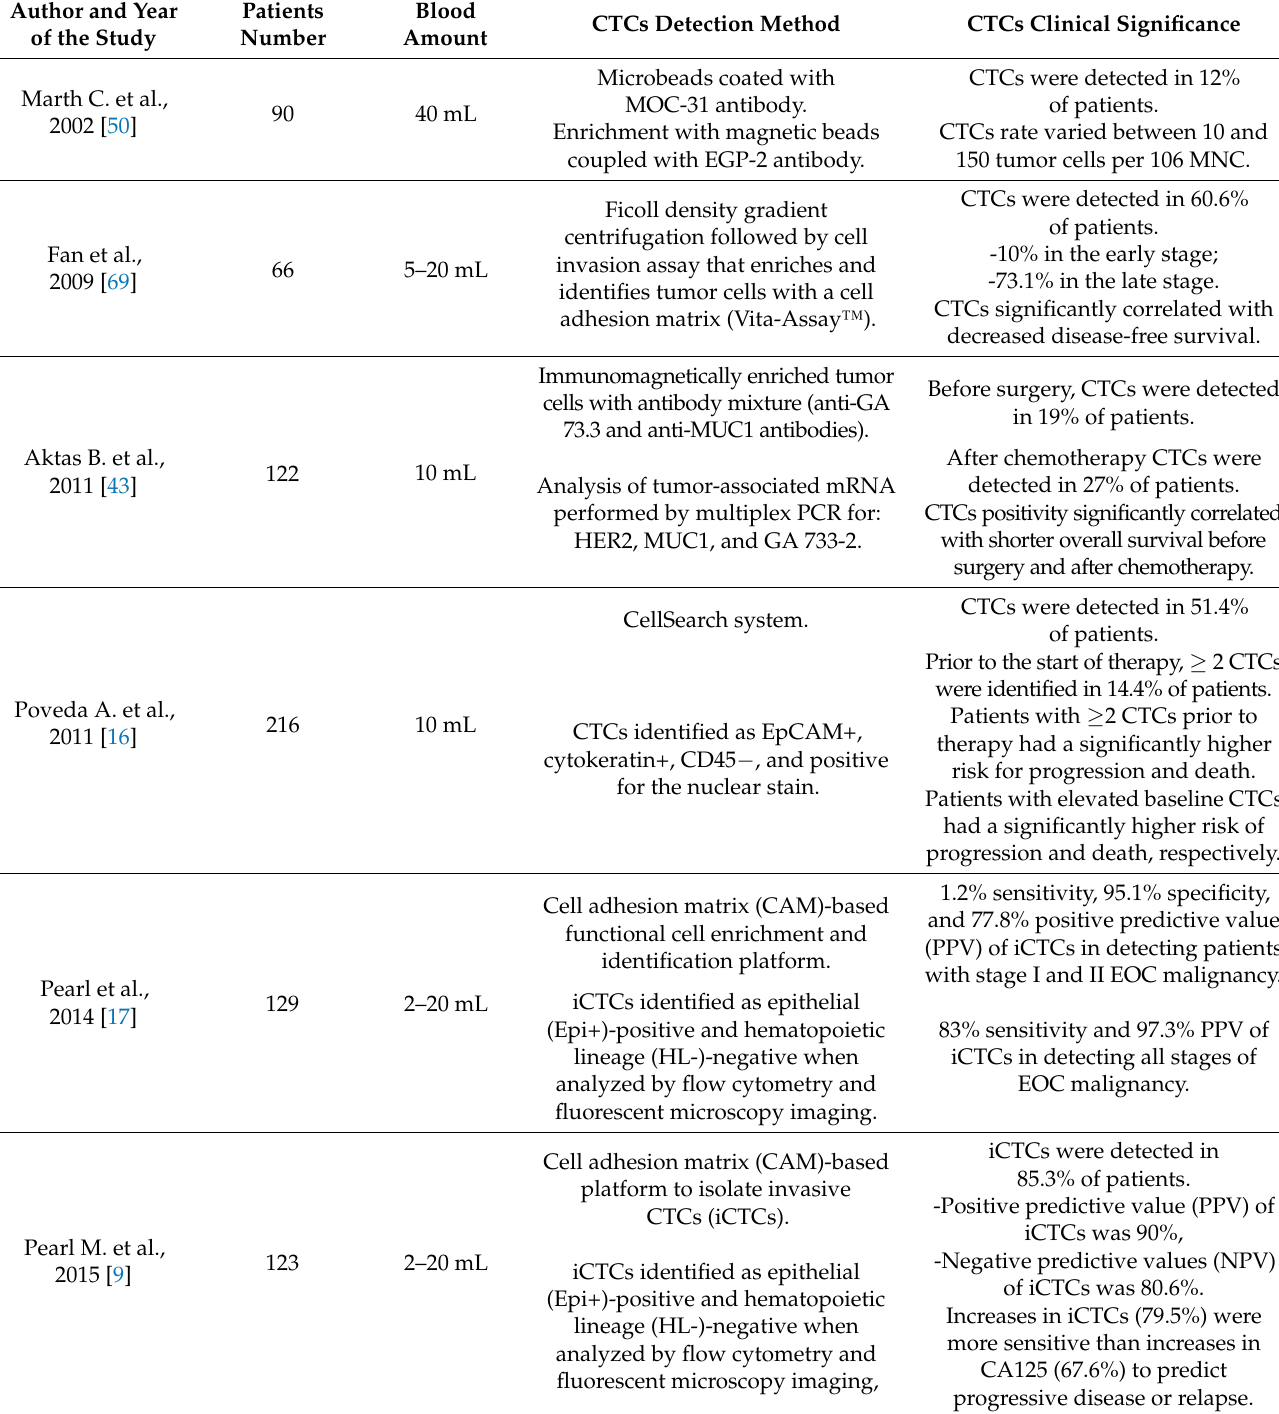
Table 1. Detection methods of ovarian CTCs and their clinical